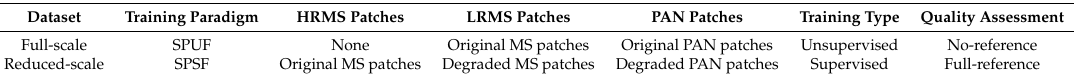
Table 2. Difference between full-scale and reduced-scale